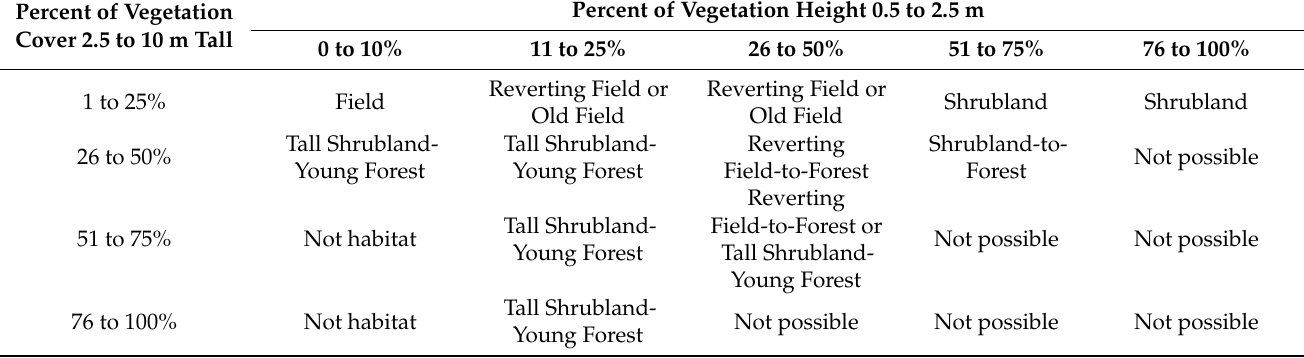
Table 2. Young forest and shrubland vegetation type definitions are based on vegetation height and percent vegetation cover by height